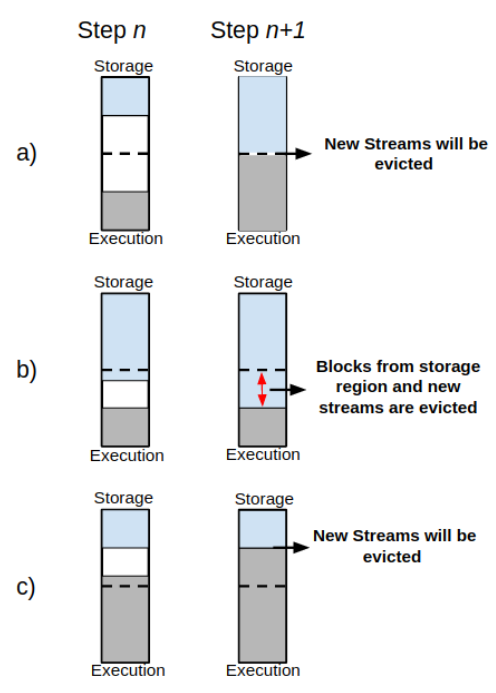
Figure 4. Memory Management